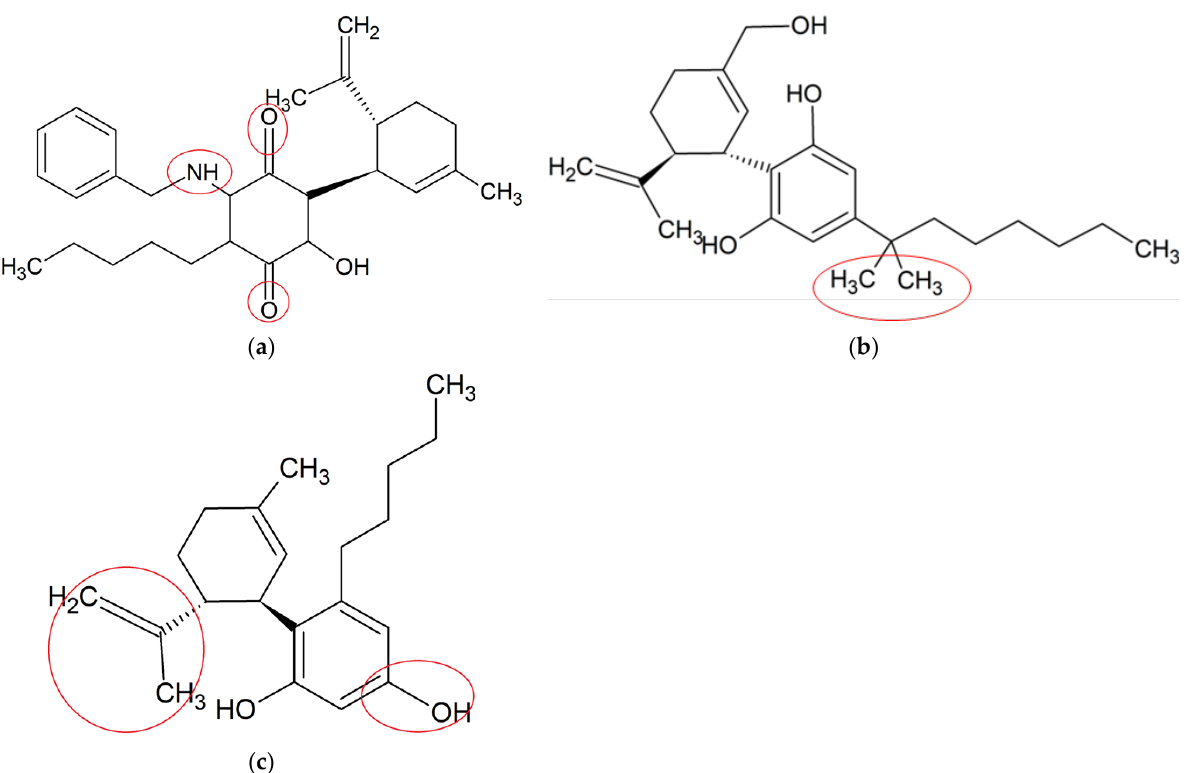
Figure 3. Chemical structures of three synthetic CBD derivatives, ( a ) VCE-004.8, ( b ) DMH-CBD and ( c ) Abn-CBD, which have shown anti-neuroinflammatory potentials. The structural modifications are highlighted by red circles.